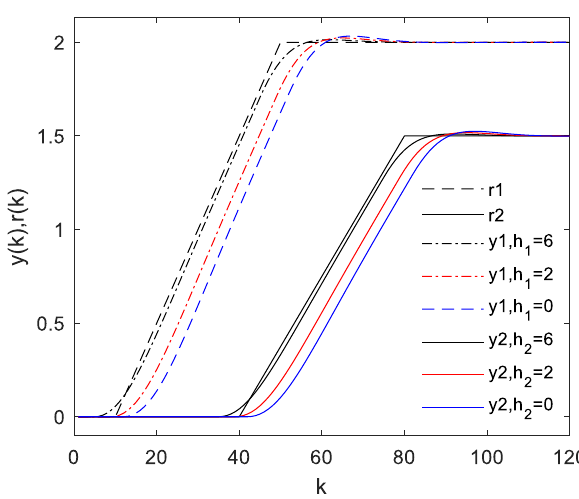
Figure 11. θ 1 = 0, θ 2 = 1, output response of system (1) with di ff erent M R .